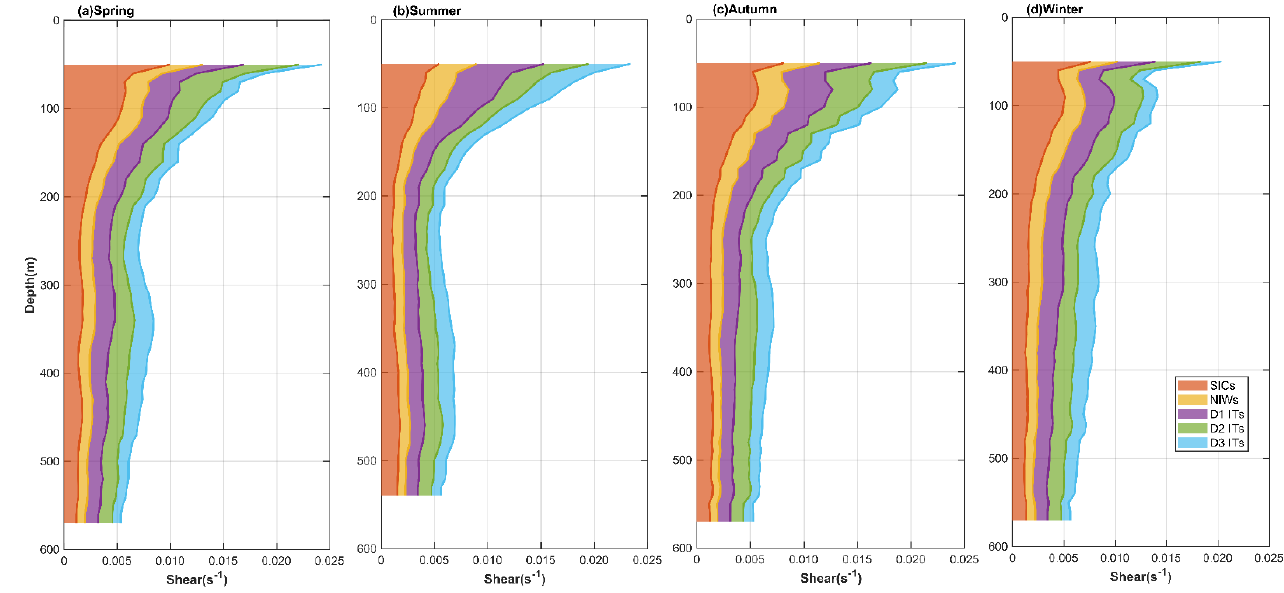
Figure 8. Vertical structures of the shear caused by motions in different frequency bands (stacked areas) in four seasons. ( a – d ) for spring, summer, autumn, and winter, respectively.